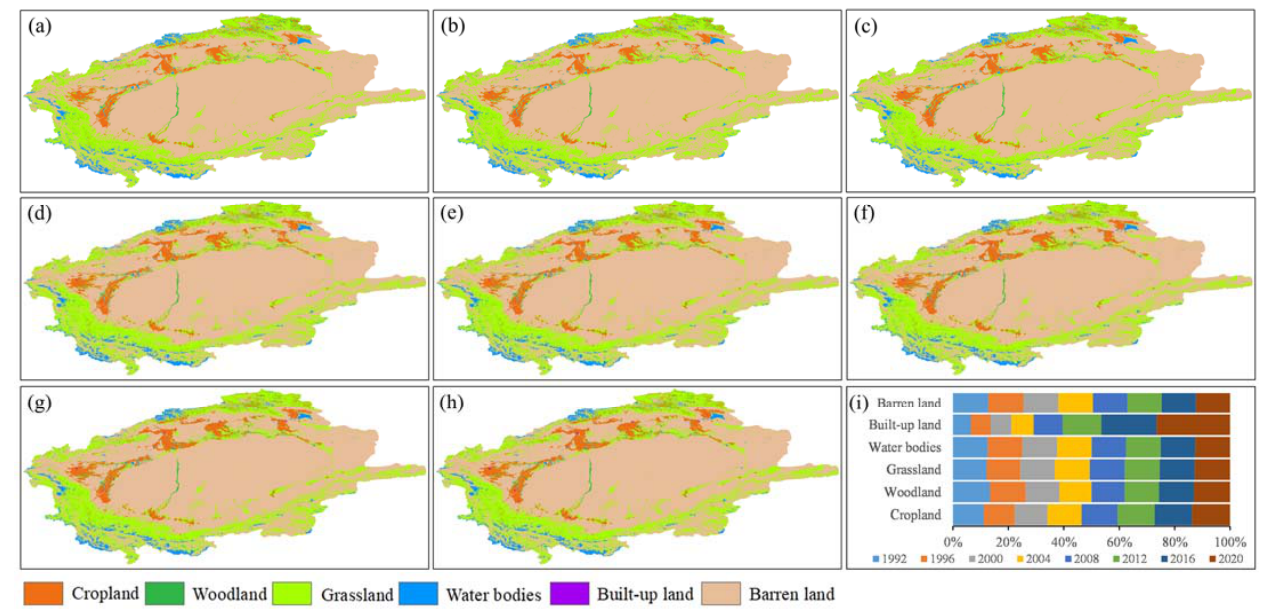
Figure 3. Land uses in the Tarim River Basin from 1992 to 2020. ( a ) 1992, ( b ) 1996, ( c ) 2000, ( d ) 2004, ( e ) 2008, ( f ) 2012, ( g ) 2016, ( h ) 2020. ( i ) The area changes of different types during the period.